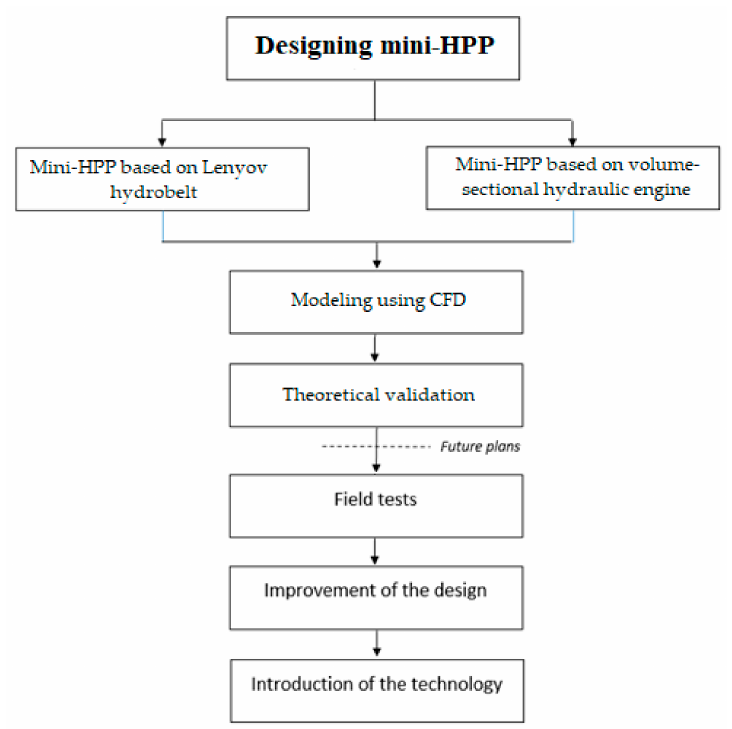
Figure 1. Flowchart of the